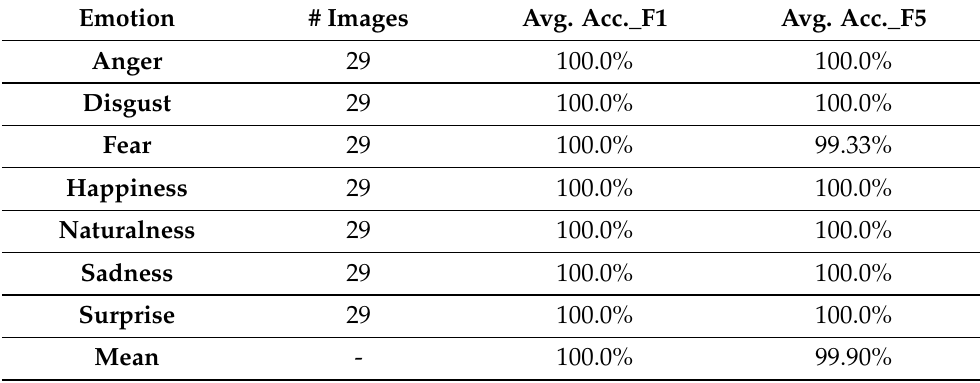
Table 3. Performance per class and average accuracy using both models, achieved with one-fold and five-fold cross-validation, on test set from KDEF dataset.